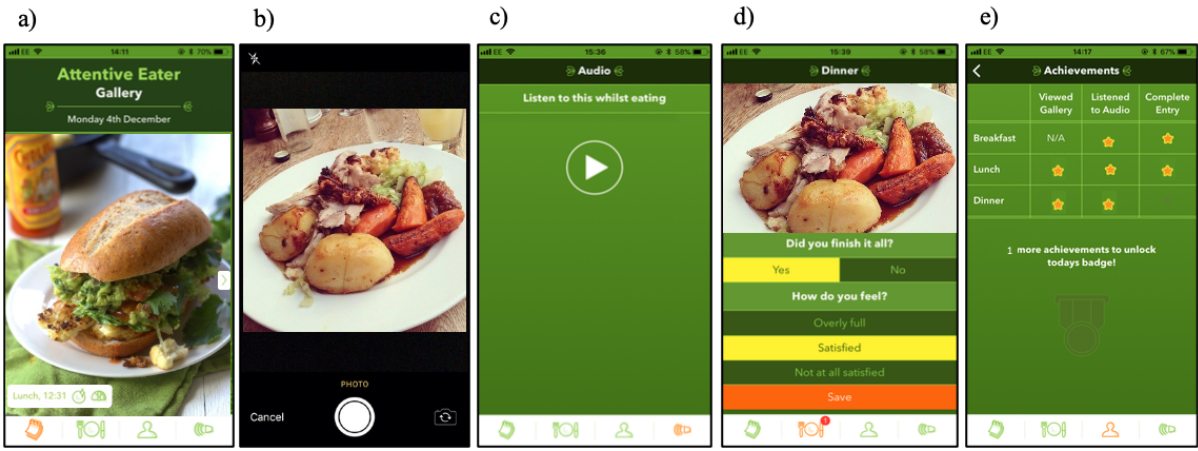
Figure 1. Screenshots of the key functions of the smartphone app: a) The food gallery; b) Photographing a meal; c) The attentive eating audio clip; d) Consumption experience questions; and e) Star and daily badge